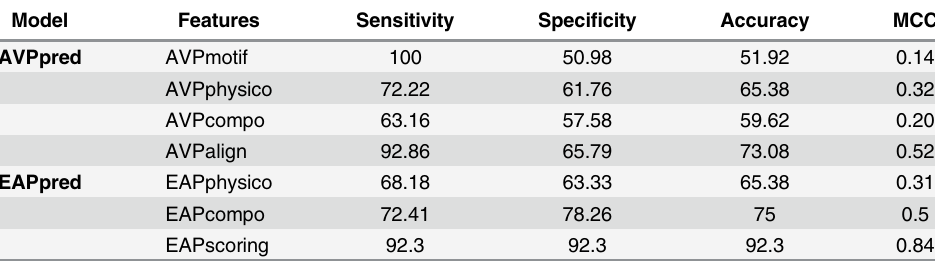
Table 3. Performance of AVPpred and EAPpred models on independent test set V 26p+26n .